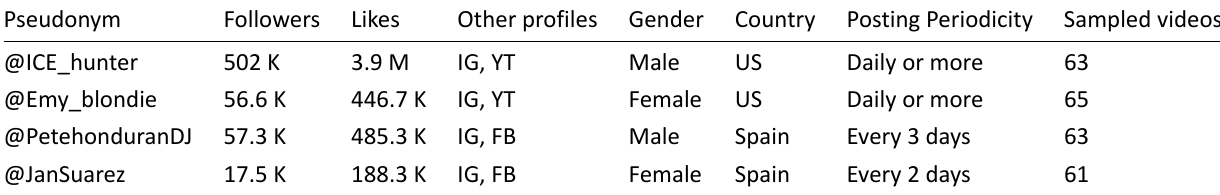
Table 1. Profiles included in the